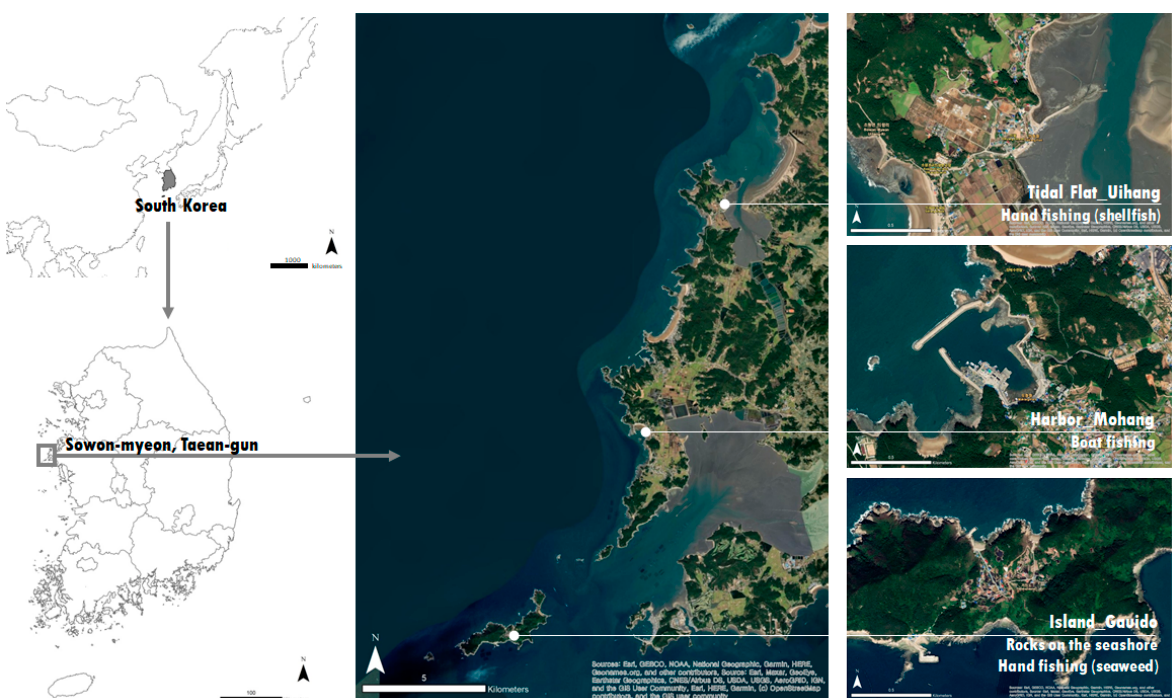
Figure 1. Geographical location of the study sites.